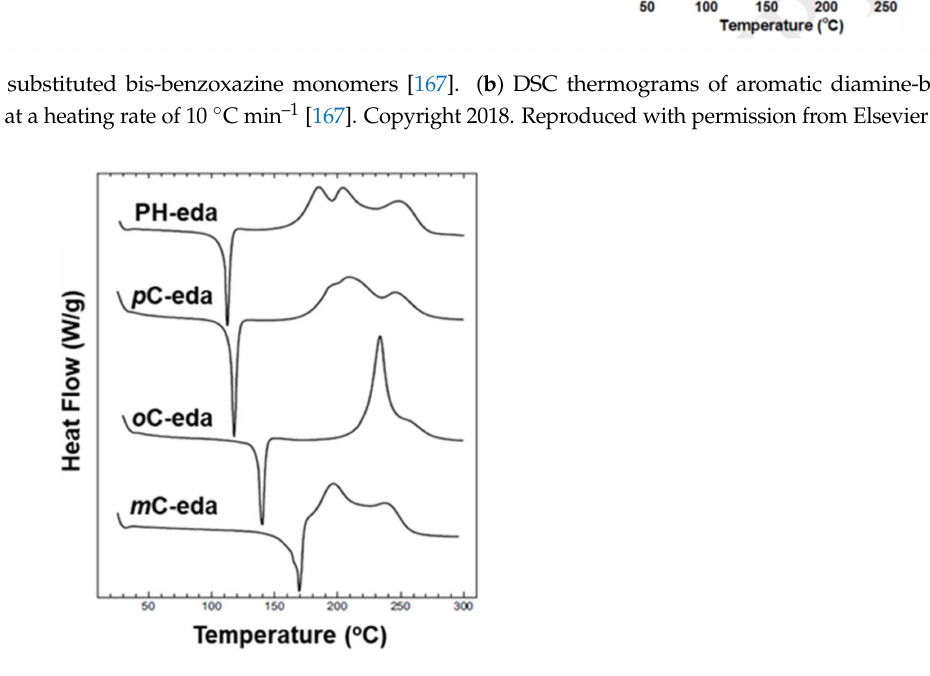
Figure 63. DSC thermograms of unsubstituted and methyl substituted phenol monomers based on ethylenediamine (eda) [137]. Copyright 2006 and 2008. Reproduced with permission from Elsevier